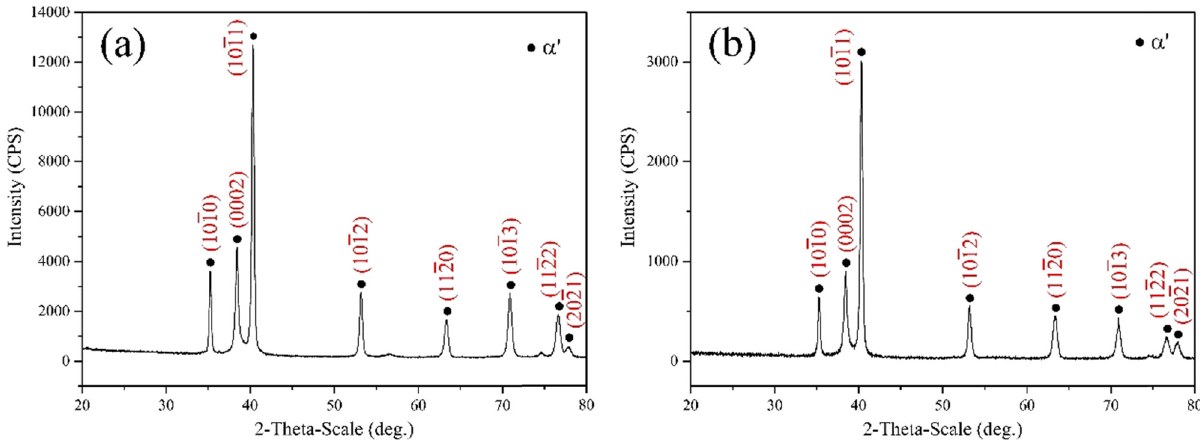
Figure 9: X - ray di ff raction pattern of weldment: ( a ) EBW joint and ( b ) P - LBW